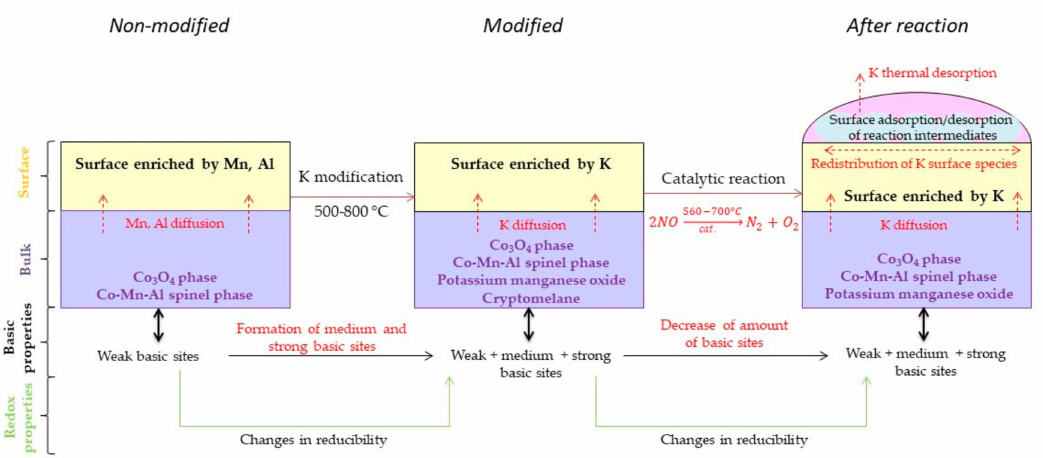
Figure 15. The schematic diagram of the potassium modified Co–Mn–Al mixed oxide catalyst changes during preparation and NO catalytic